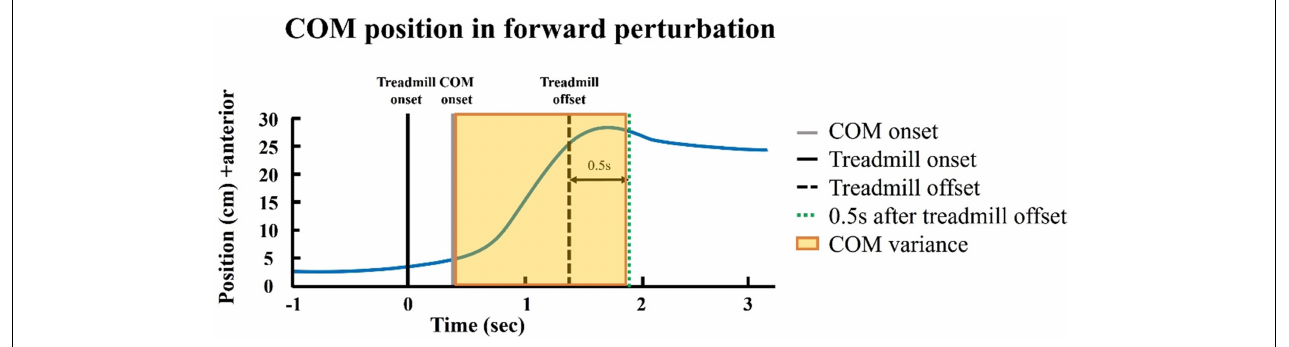
FIGURE 4 | The center of mass (COM) variance in the forward